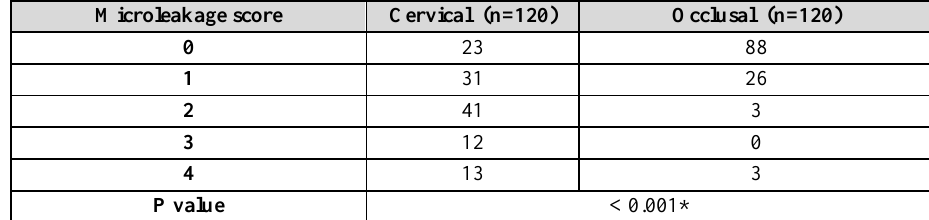
Table 4: Microleakage scores of all cervical walls compared to that of all occlusal walls. Microleakage score